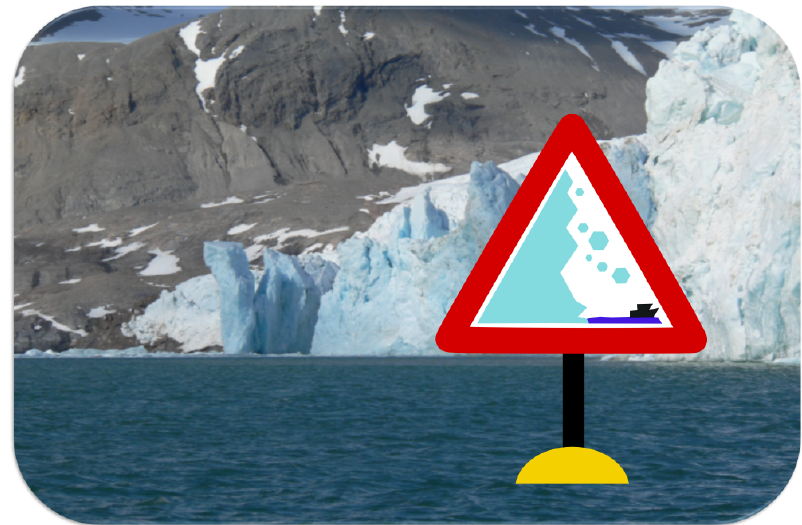
Figure 3. A picture showing the dangerous and non-navigable area in front of the Blomstrandbreen tidewater glacier.